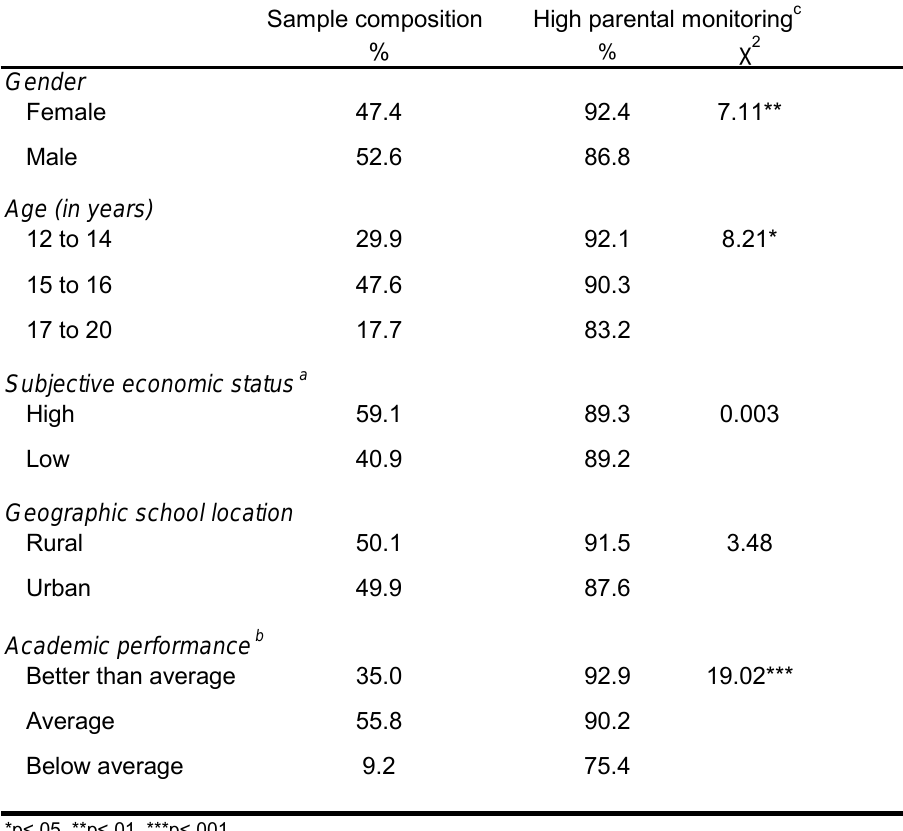
Table 1. Prevalence (%) of high parental monitoring by descriptive characteristics, public secondary school students from central El Salvador, 1999. (n =